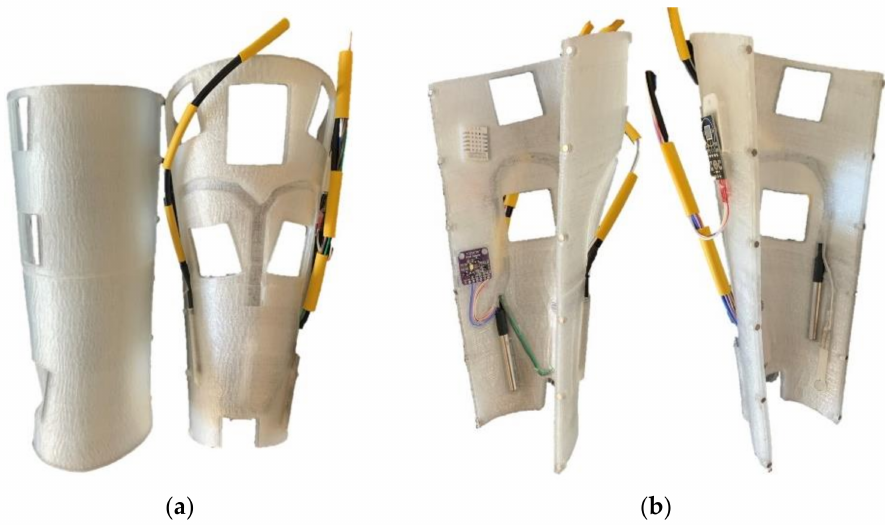
Figure 13. Real splint assembled with the sensors ( a ) and interior view ( b ).